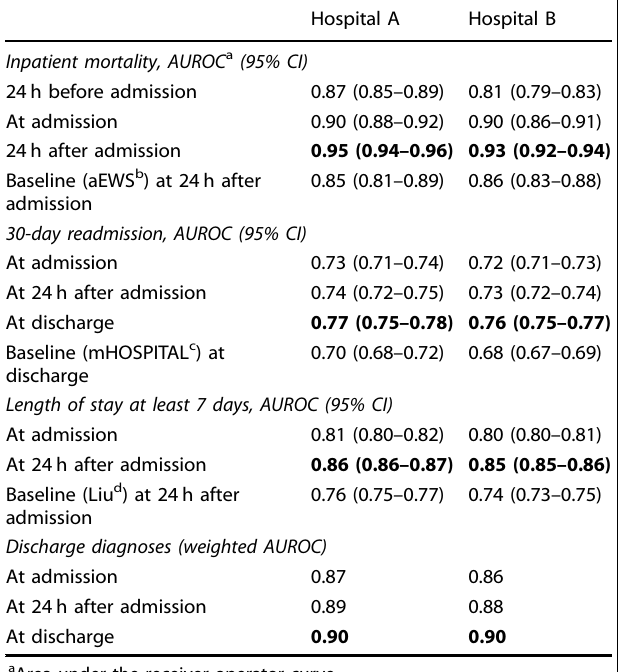
a Area under the receiver operator curve b Augmented Early Warning System score c Modi fi ed HOSPITAL score for readmission d Modi fi ed Liu score for long length of stay The bold values indicate the highest area-under-the-receiver-operator- curve for each prediction